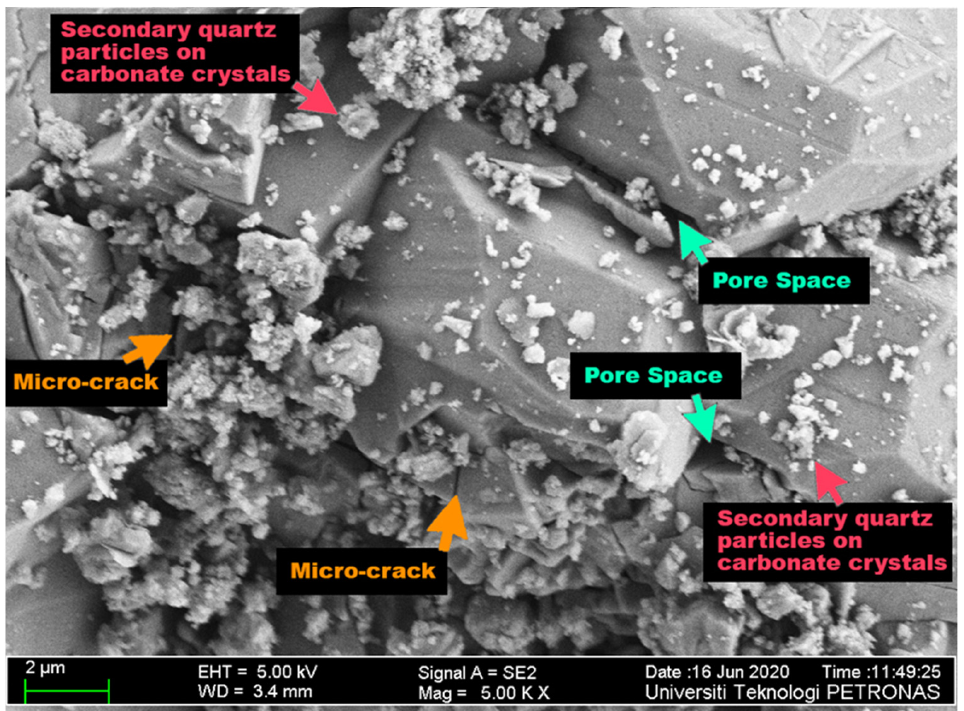
Figure 8. FESEM image of sample A-2.1 before permeability measurement.